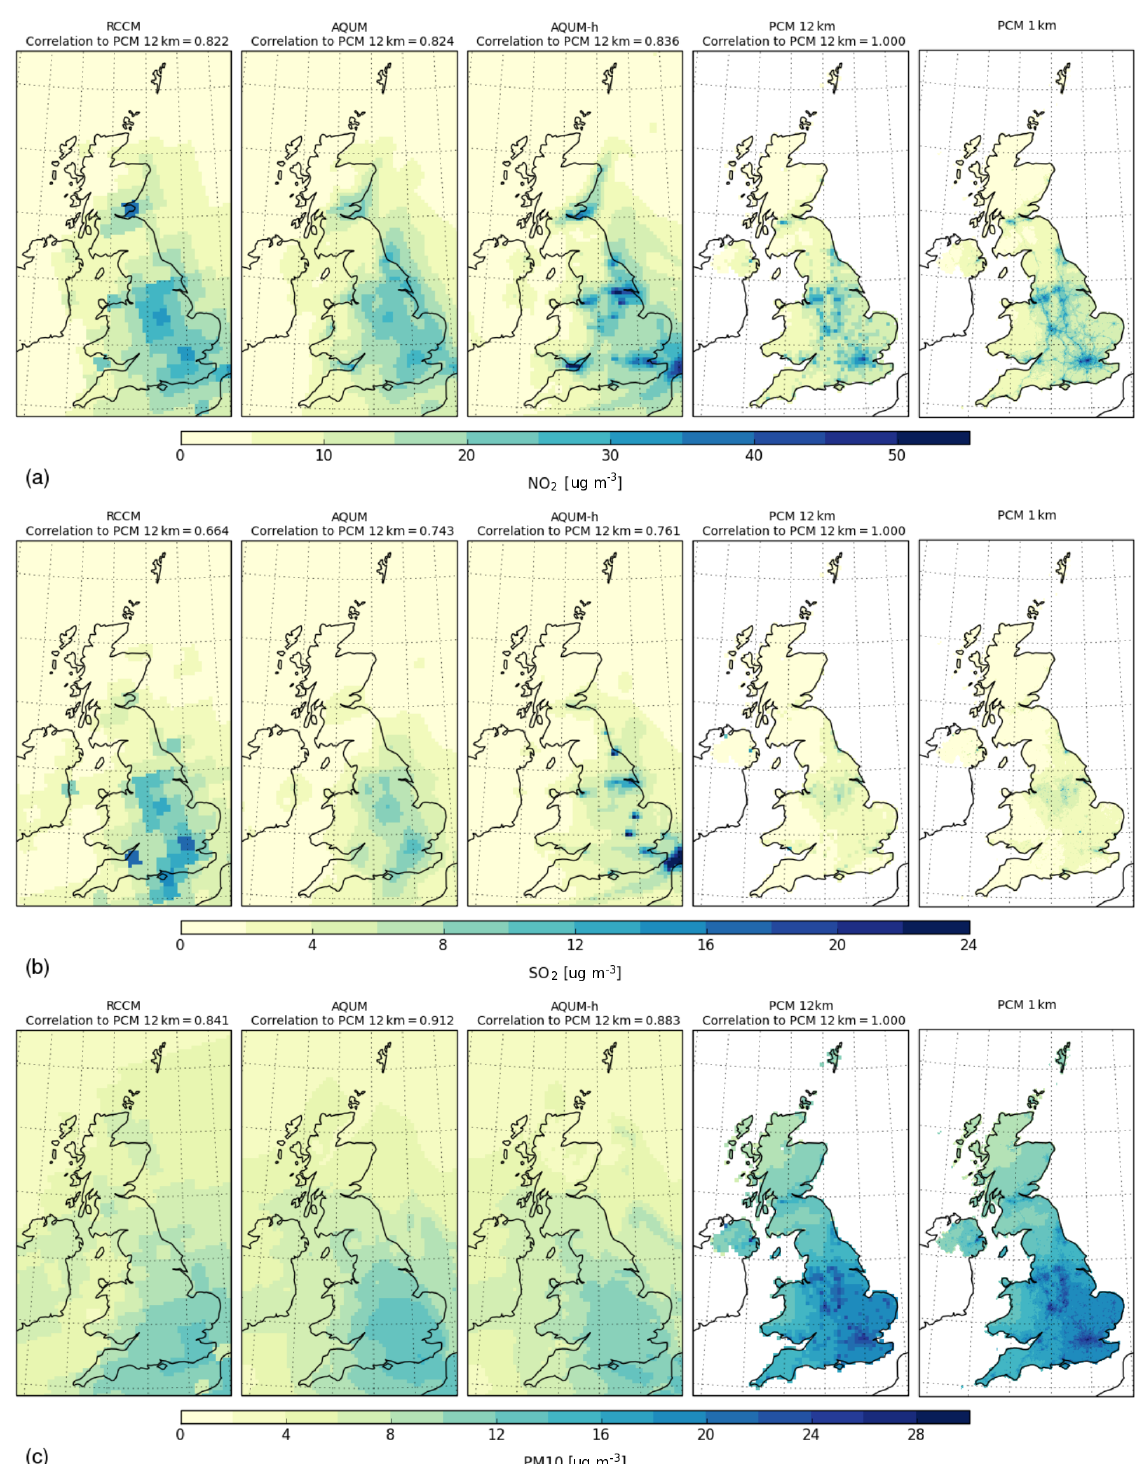
Figure 6. Model and PCM mean fields for different pollutants, regridded onto a 12km AQUM grid. From left to right the models are RCCM, AQUM, AQUM-h, a 12km version of the PCM, and finally the 1km PCM for comparison. Plots also show the correlation between the fields and the 12km version of the PCM. Pollutants shown are (a) NO 2 (top row), (b) SO 2 (middle), and (c) PM 10